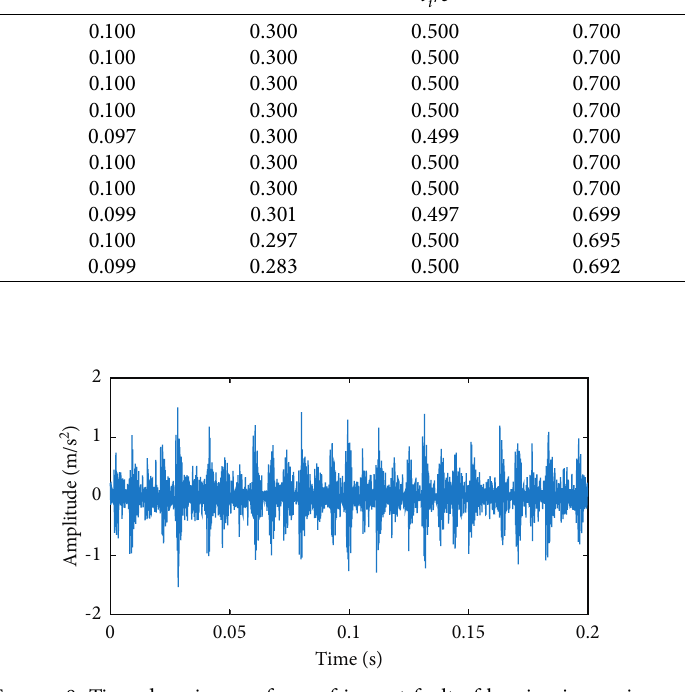
Figure 8: Time-domain waveform of impact fault of bearing inner ring.